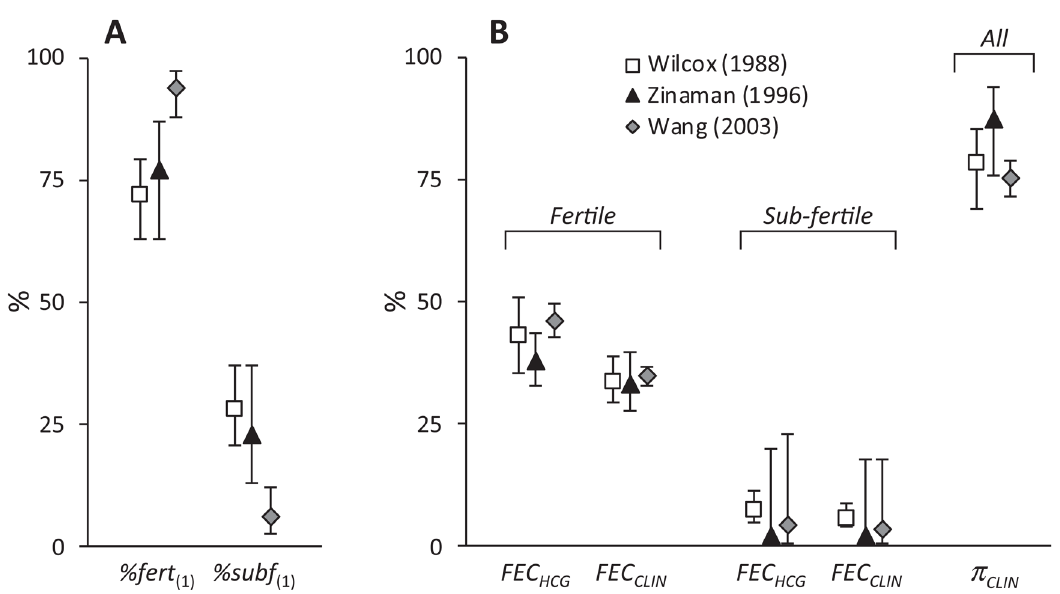
Figure 2. Parameter estimates for fertile and sub-fertile sub-cohorts and associated fecundability values. Values are shown for Wilcox ( ), Zinaman (  ) and Wang ( ) studies. Panel A shows the proportions in the starting cohorts modelled as fertile or sub-fertile (% fert % subf ). Panel B shows the hCG ( FEC ) and clinical ( FEC ) fecundabilities and the probability of hCG pregnancies progressing to clinical (1) HCG CLIN pregnancies ( π ). Values are derived from modelled parameter estimates (Table 1) and error bars indicate 95% confidence CLIN